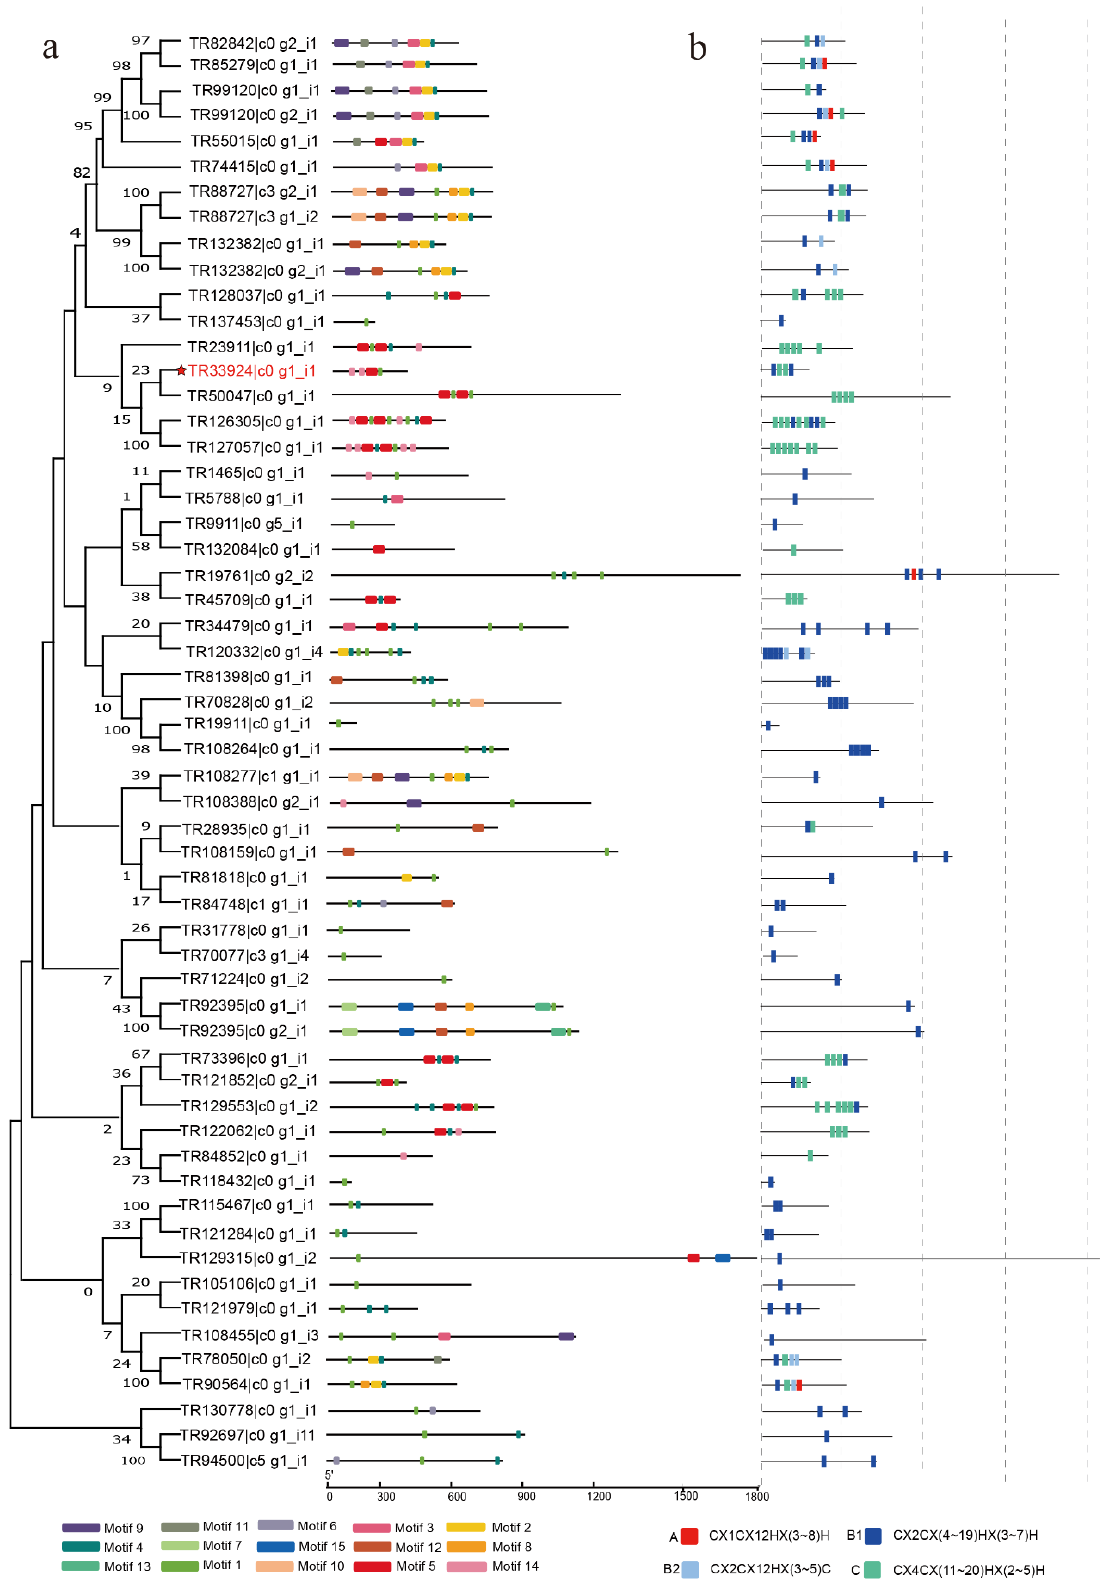
Figure 2. Motif and gene structures of C2H2 protein members in B. argenteum : ( a ) structure of con- served motifs; ( b ) different ZF types. conserved motifs; ( b ) different ZF